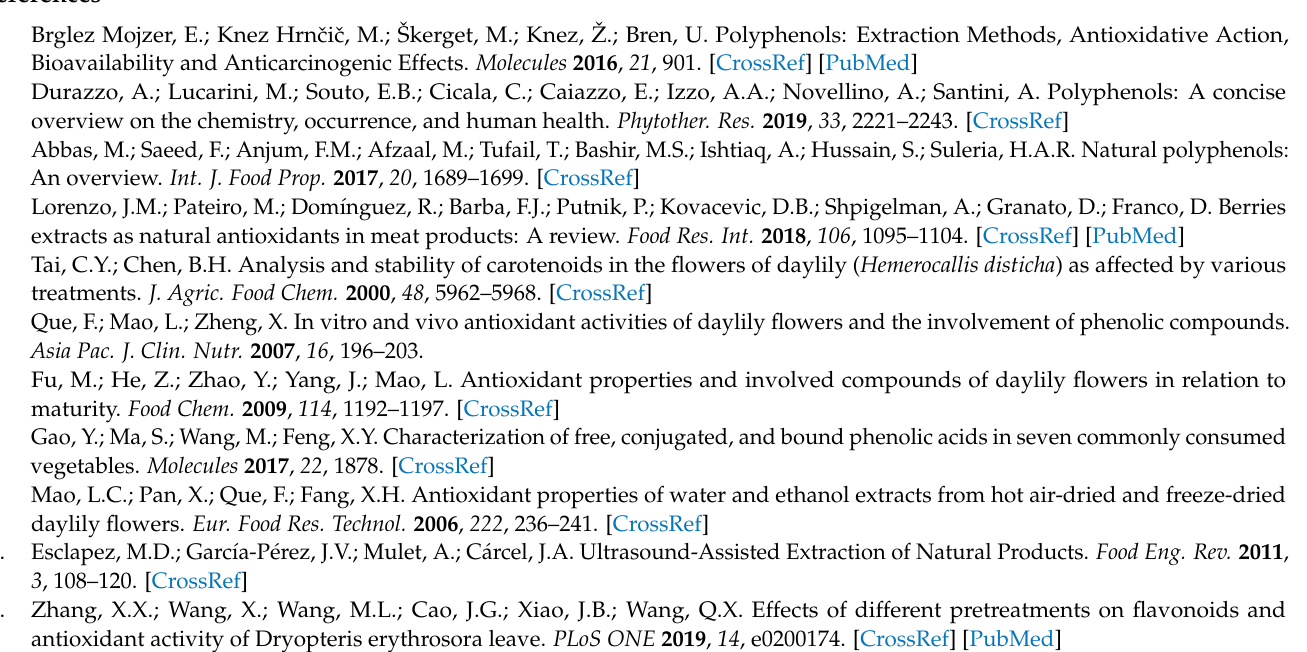
Figure S1: MS/MS spectra of daylily ( Hemerocallis citrina Baroni) using